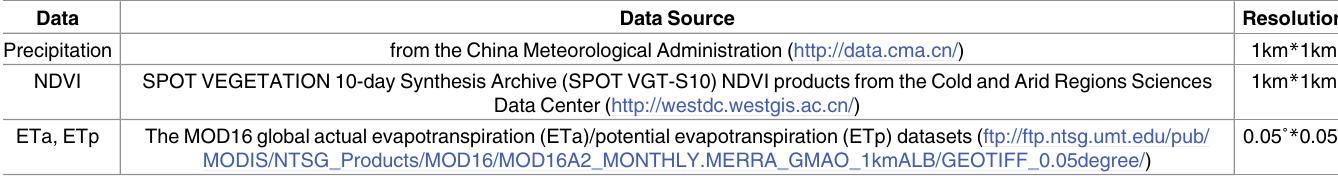
where N is determined by the vegetation conditions. Eq 3 can be solved by the numerical method [43]. In our study, the value of N was different under different NDVI conditions. K. Miegel et al. has also illustrated the relationship between the evapotranspiration efficiency (ETa/ETp) and the potential humidity (P/ETp) for given different values of N. However, the actual evapotranspiration was considerably influenced by the vegetation cov- erage. Thus, we considered the impacts of the vegetation coverage, added the variable NDVI to the equation and revised the Bagrov model to simulate the ETa values. The equation was Table 3. Main datasets